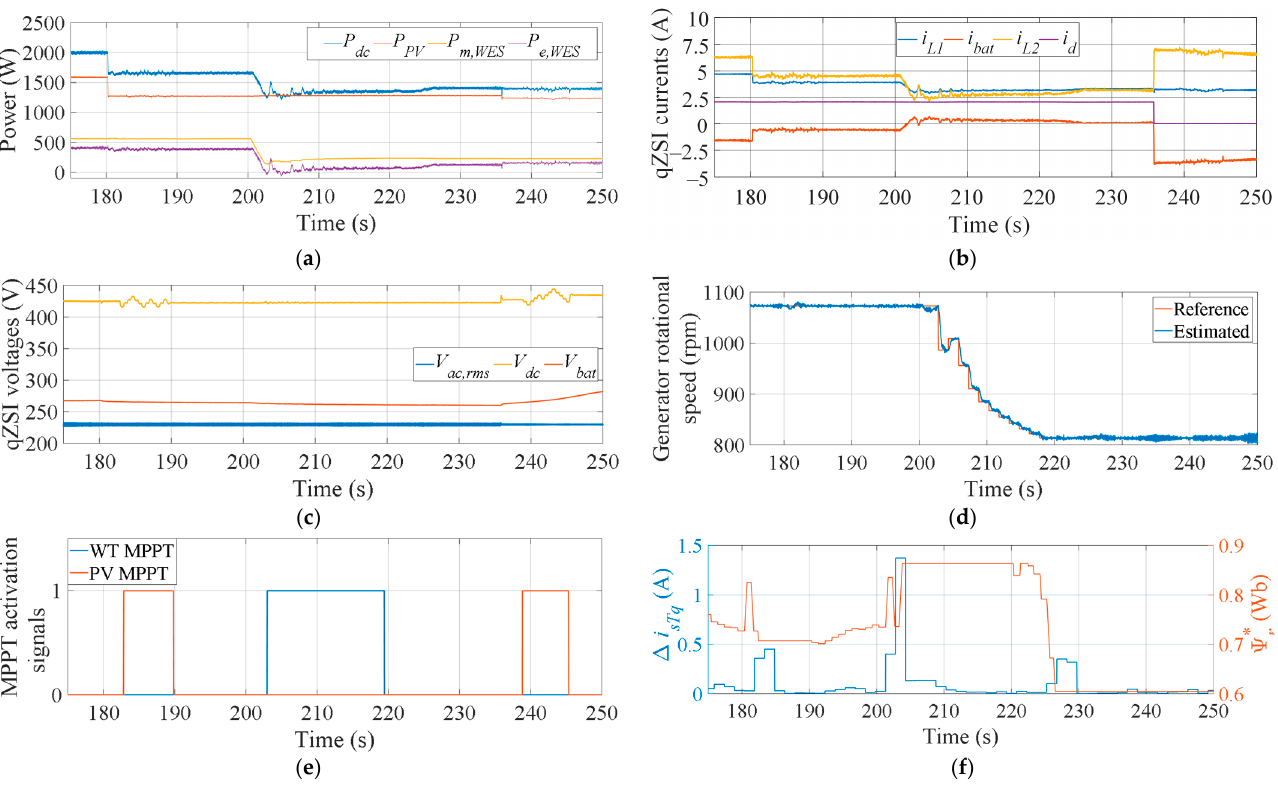
Figure 16. Dynamic responses to load, irradiance, and wind speed changes in the selected time interval (175–250 s): ( a ) electrical powers and WT mechanical power; ( b ) qZSI currents; ( c ) qZSI voltages; ( d ) generator rotational speed; ( e ) MPPT algorithms activation signals; ( f ) SCIG torque- related current change and rotor flux reference value.